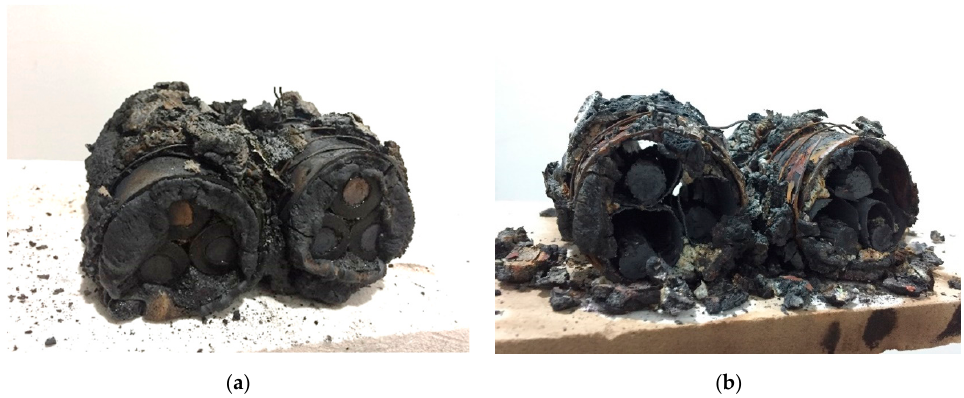
Figure 11. Photographs of Cable ZRC-YJV-8.7/10 3 × 95 mm 2 samples after each test: ( a ) after Test 1 at 24.9 kW/m 2 ; ( b ) after Test 2 at 28.3 kW/m 2 .